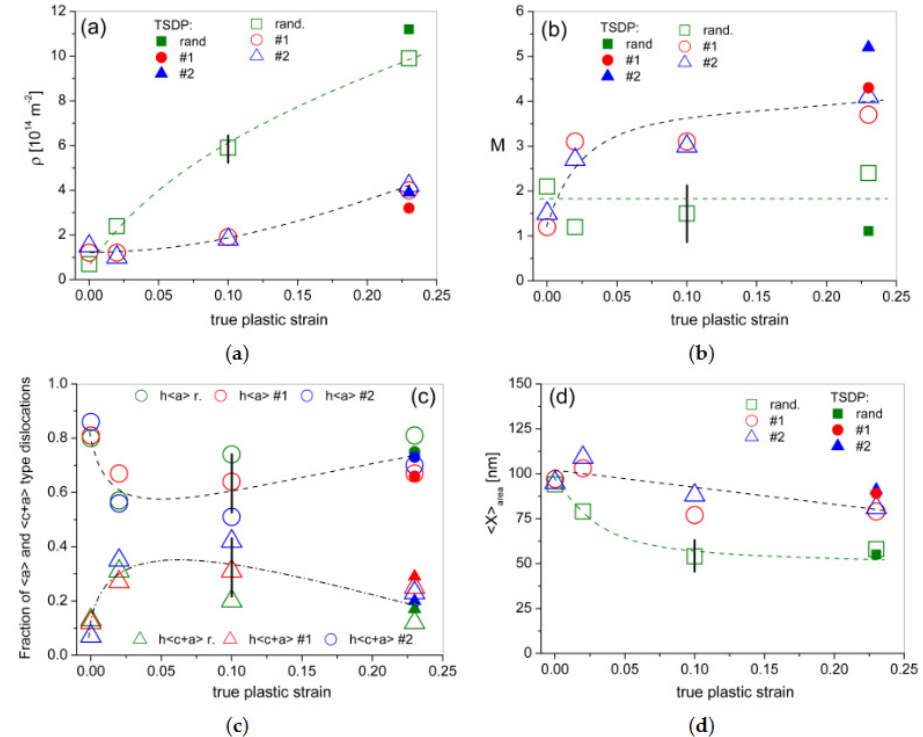
Figure 9. ( a ) Dislocation density ρ , ( b ) dislocation arrangement parameter M , ( c ) fraction of (cid:104) a (cid:105) and (cid:104) c + a (cid:105) type dislocations and ( d ) area-weighted average crystallite size (cid:104) x (cid:105) area versus the true plastic strain for the di ff erent texture components separately. Open symbols are obtained by multi-phase fitting and filled symbols represent results obtained from the evaluation of TSDPs for the 23% deformed specimen. Trend lines are drawn only to guide the eyes. The thick vertical lines at selected data show the representative error of the parameter values.